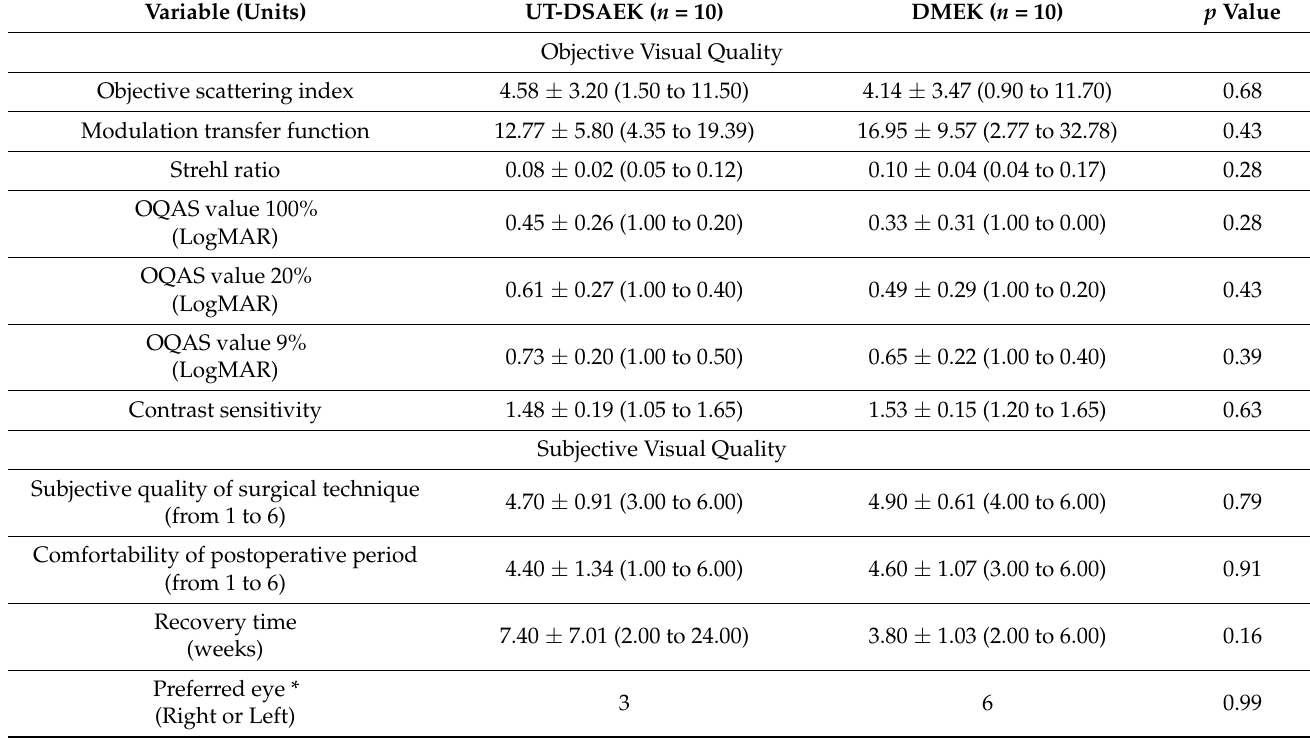
Table 2. Postoperative objective and subjective visual quality differences between UT-DSAEK and DMEK. Variable